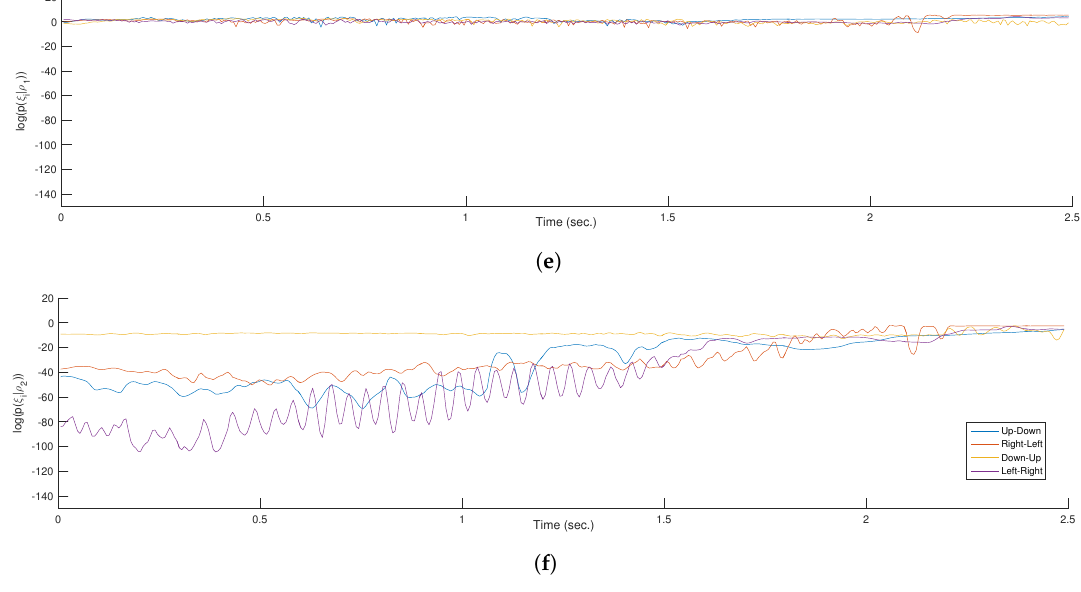
Figure 9. Trained surface contact ( a ) and lever effect ( b ) GMMs, and their fitnesses with the surface contact gesture interaction measurements from the evaluation movements. Log-likelihood of the surface contact gesture interaction measurements for both gestures ( c , d ). ( a ) Interaction forces vs. surface contact gesture GMM; ( b ) interaction torques vs. surface contact gesture GMM; ( c ) interaction forces vs. lever effect gesture GMM; ( d ) interaction torques vs. lever effect gesture GMM; ( e ) log-likelihood that the interaction measurement tuple ξ i , obtained each i instant time, belongs to the surface contact GMM ρ 1 ; and ( f ) log-likelihood that the interaction measurement tuple ξ i , obtained each i instant time, belongs to the lever effect GMM ρ 2